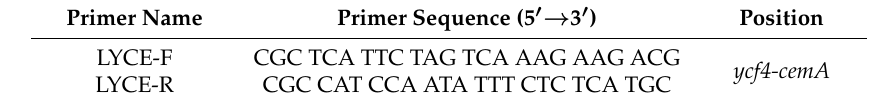
Table 2. Primers used for the development of the indel marker.